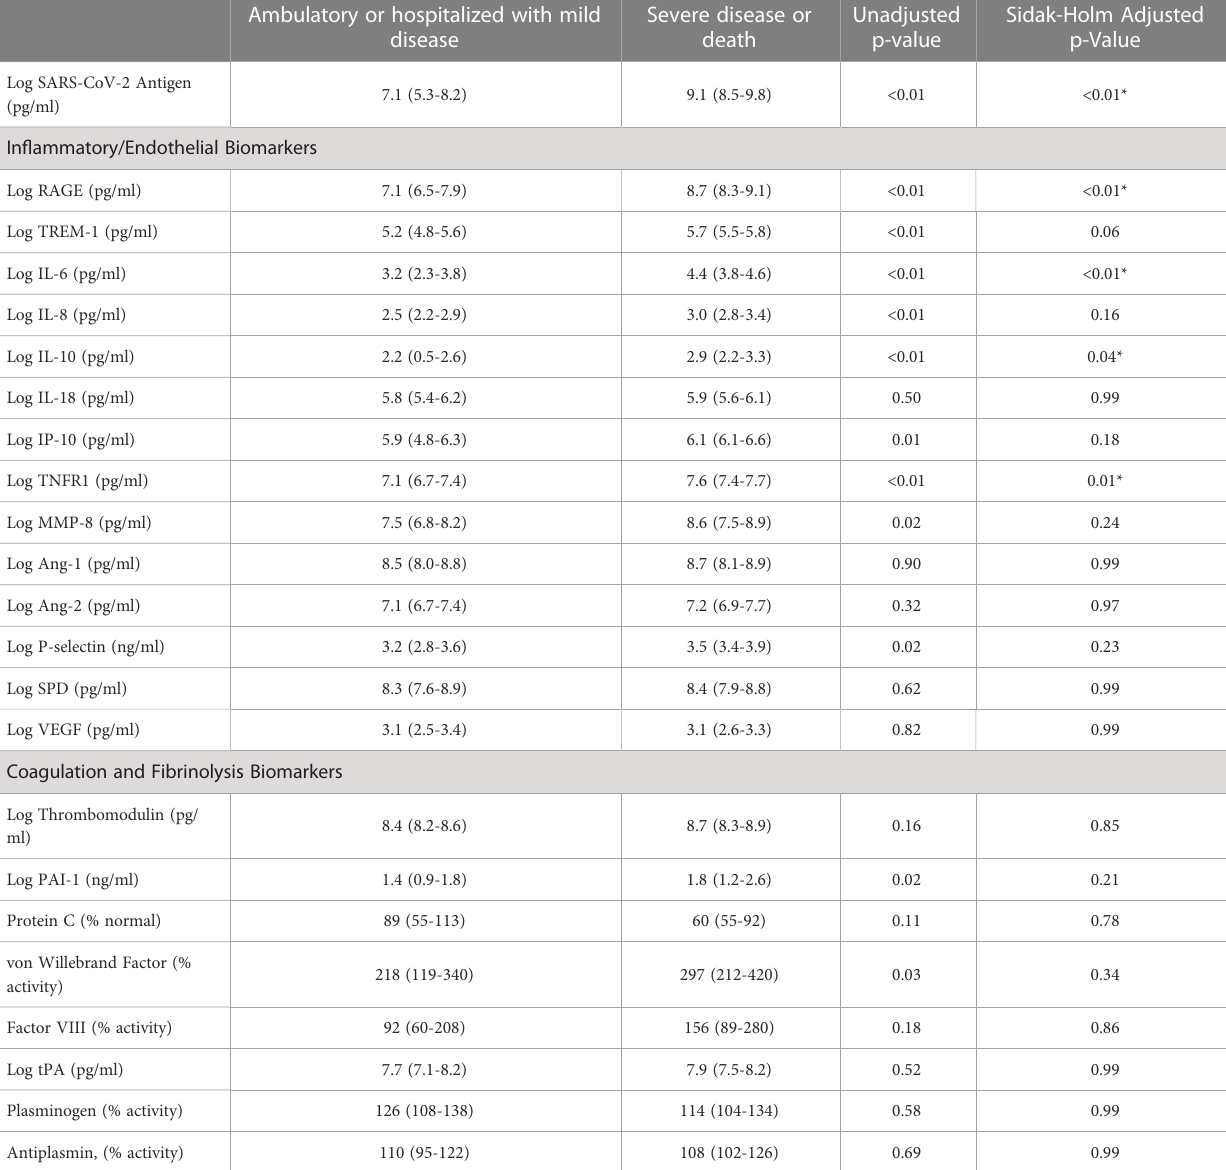
TABLE 2 Comparison of thromboin fl ammatory biomarkers among patients with COVID-19 by ultimate disease